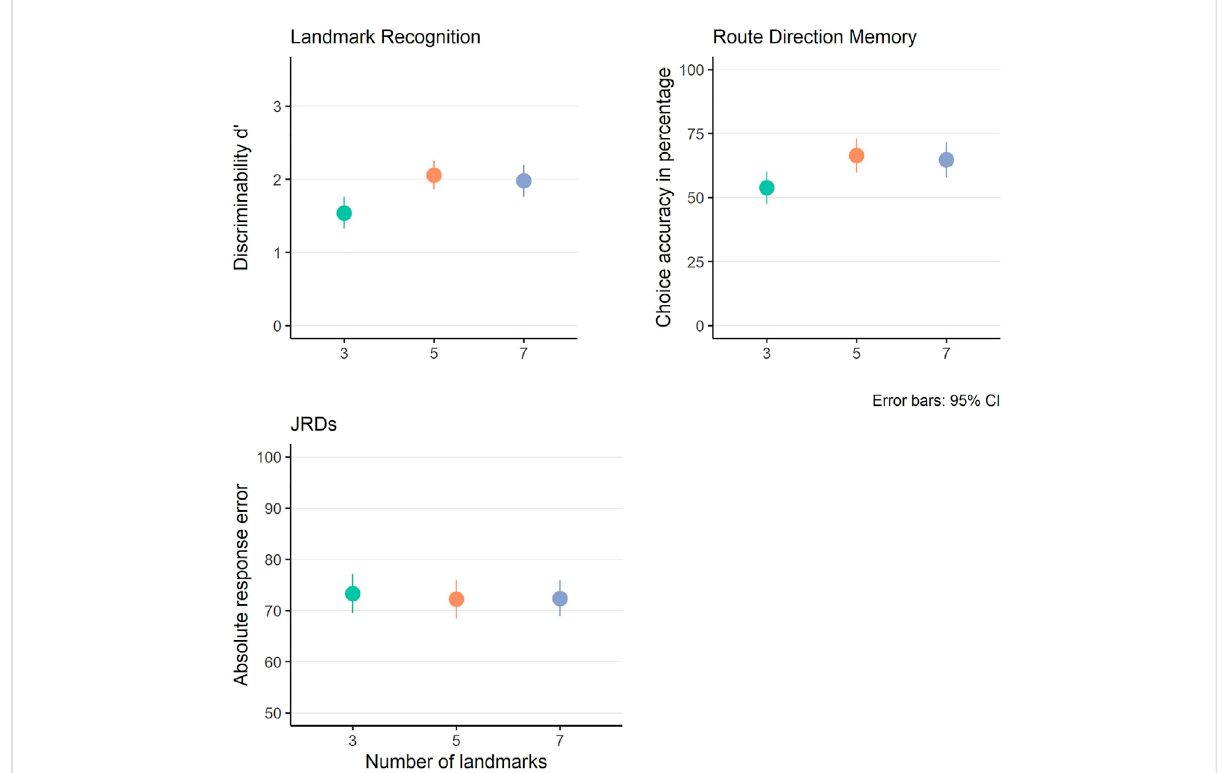
FIGURE 5 Landmark and route learning improved when more than three landmarks were shown. No improvement was observed in JRD performance when more landmarks were shown. The means of d ’ , choice accuracy, and absolute response error in each landmark condition are presented in the three plots with the error bars representing the 95% CI of the